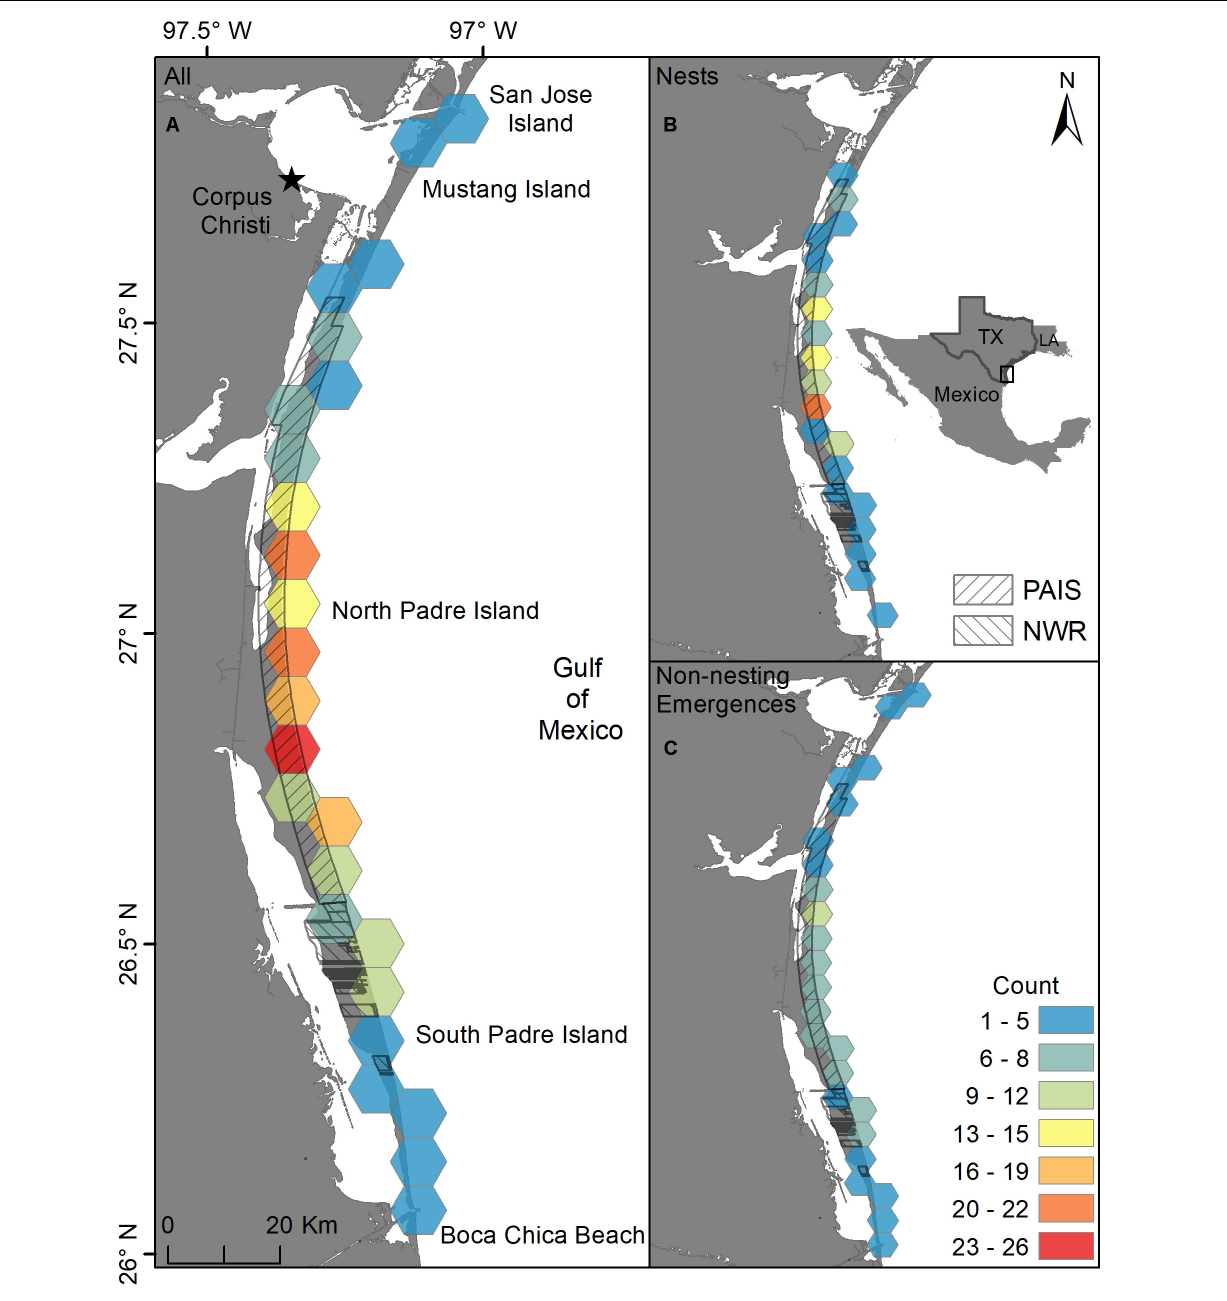
FIGURE 1 | Ten km hex-bin density of all green turtle ( Chelonia mydas ) nesting activity (nests and non-nesting emergences) in Texas from 1987 to 2019. (A) Density of all nests and non-nesting emergences, (B) density of all nests, (C) density of all non-nesting emergences. PAIS = Padre Island National Seashore, NWR = Laguna Atascosa and Lower Rio Grande Valley National Wildlife